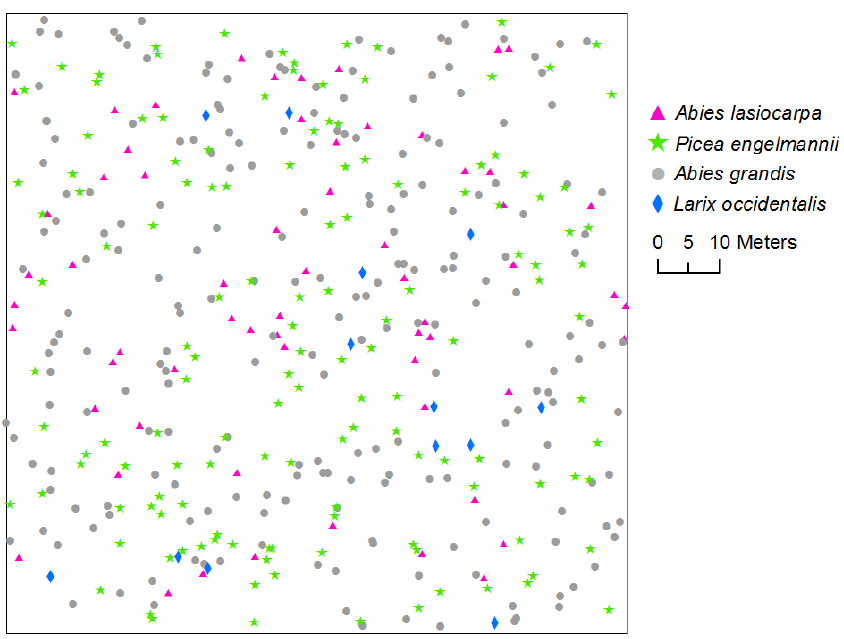
Figure 3. Map of the tree locations for the uneven-aged mixed-conifer stand in eastern Oregon (western United